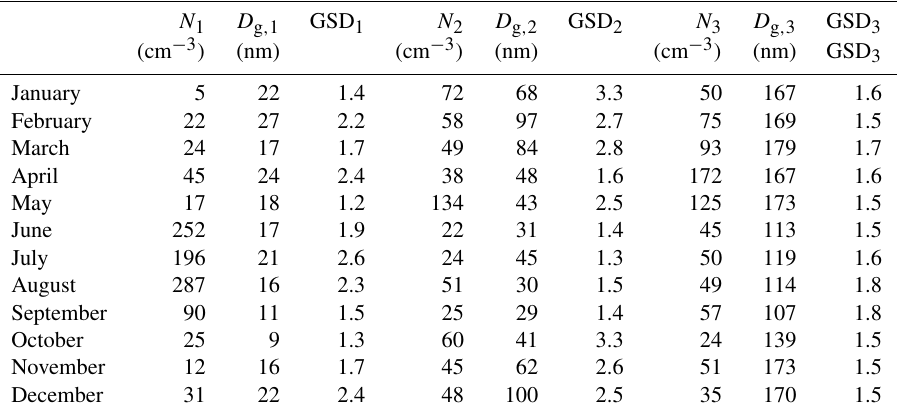
Table 1. Three modes were fitted to the average monthly data of 2012 using log-normal fitting. The parameters shown for each mode include the modal number concentration ( N , cm − 3 ) , the modal geometrical mean diameter ( D g , nm) and the modal geometrical standard deviation (GSD). A fitted sum of three log-normal distributions was calculated for the entire particle size range (averaged monthly particle number size distributions), and the difference of the sum of the squares of each number concentration at the specific sizes between the real and the fitted data was minimized using the Excel solver add-in.